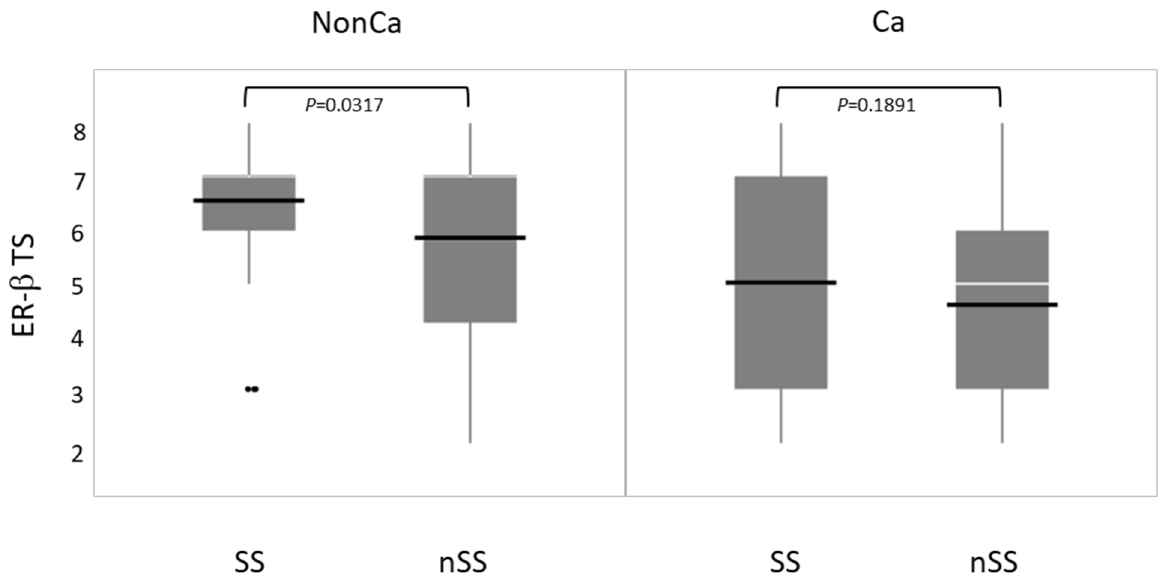
Figure 5. The relation between ESR2 cytosine-adenine ( ESR2 -CA) genotype and ER- β expression (total score, TS) in non-cancerous (NonCa) and cancerous (Ca) tissues by boxplots. White horizontal bar, median; black horizontal bar, medium. In NonCa, but not in Ca, ER- β expression was significantly higher in SS than in nSS. Ca, cancerous tissue; NonCa, non-cancerous tissue.